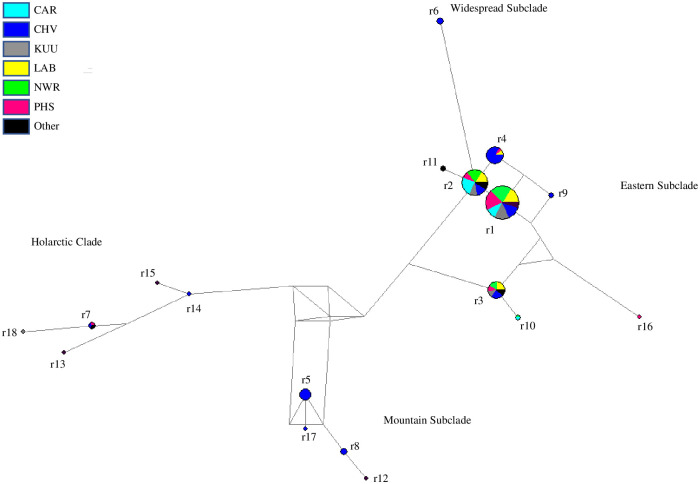
Median spanning network of 18 red fox mitochondrial control region haplotypes generated using network 5.0.Circles representing haplotypes are scaled according to frequency, with proportional membership in sampling localities as indicated in the key. Sample locality codes are given in Table 1.